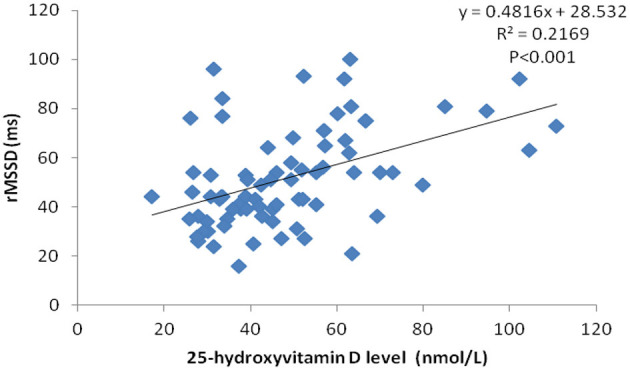
Correlation scatter plot between serum 25-hydroxyvitamin D level and rMSSD in VVS patients.